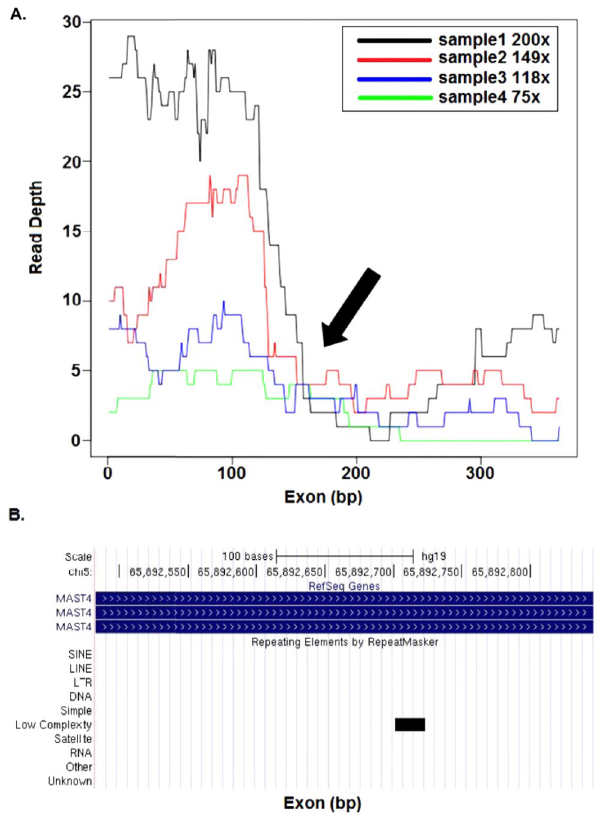
Figure 5. Concurrence of repeat elements and coverage sparseness. ( A ) Base coverage distribution along the length of the first coding exon of MST4 . WES samples from the NimbleGen platform with different average coverage ranging from 75X to 200X are shown in different colors. Arrow indicates the point at which coverage falls sharply. ( B ) UCSC browser screen shot of MST4 genomic region, black bar indicates the position of the repeat